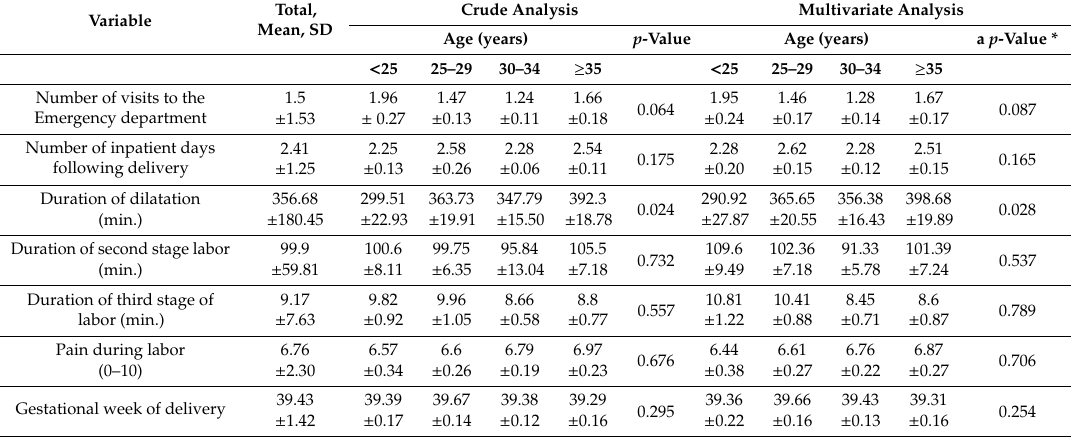
Table 4. Association between maternal age and di ff erent continuous variables during pregnancy, labor and the puerperium. Crude Analysis Multivariate Analysis Total, Variable Mean, SD Age (years) p -Value Age (years) a p -Value *